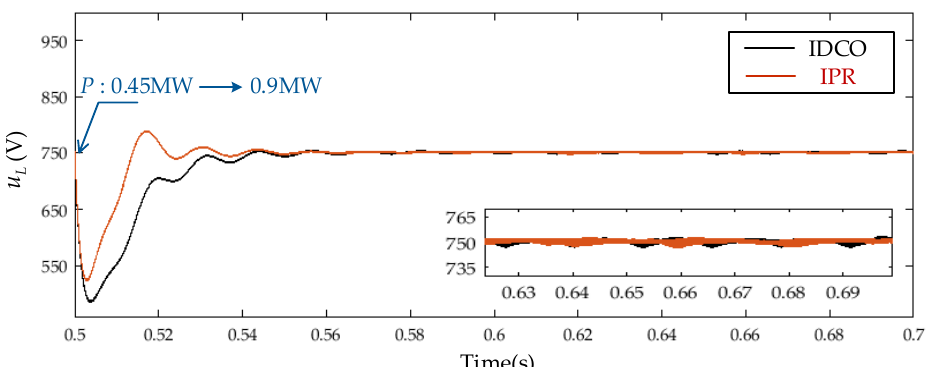
Figure 21. Dynamic waveforms of the LV bus voltage u L based on the IDCO or IPR control method under a load step-change.